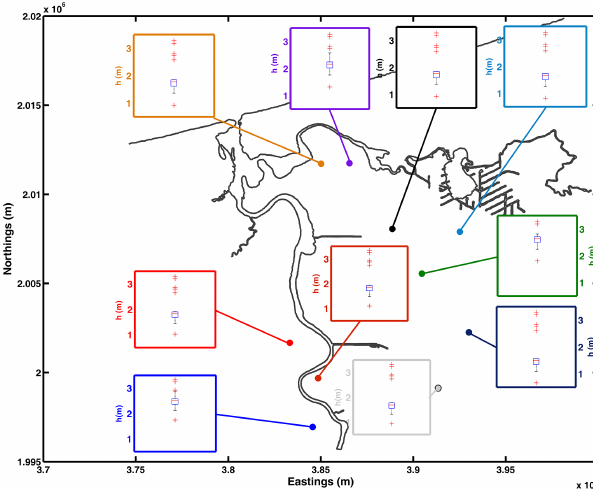
Figure 10. Estimated maximum inundation depths at different lo- cations within the floodplain. Red line represents the median. Bars correspond to the standard deviation. Upper and lower limits of the box are the values of the 25th and 75th percentiles, respectively. Crosses depict